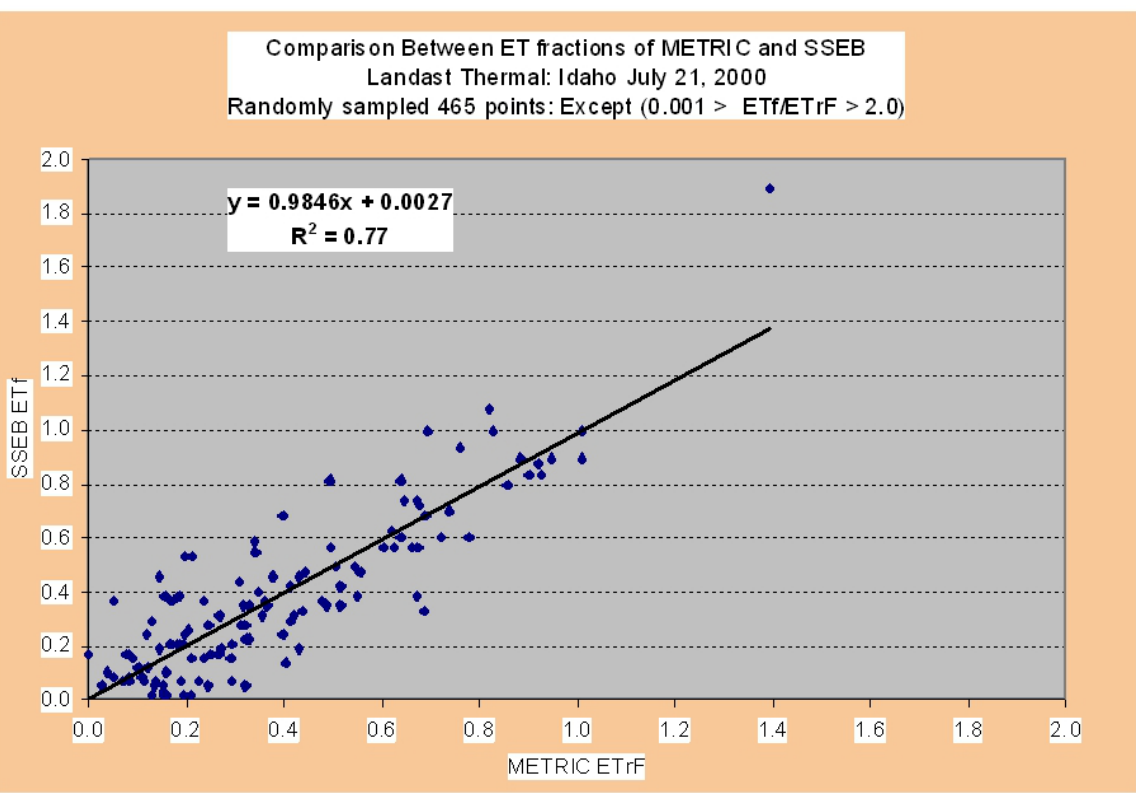
Figure 15. Comparison between ET fraction from METRIC and SSEB models (personal correspondence with Dr. Gabriel Senay developer of SSEB and Dr. Rick Allen developer of